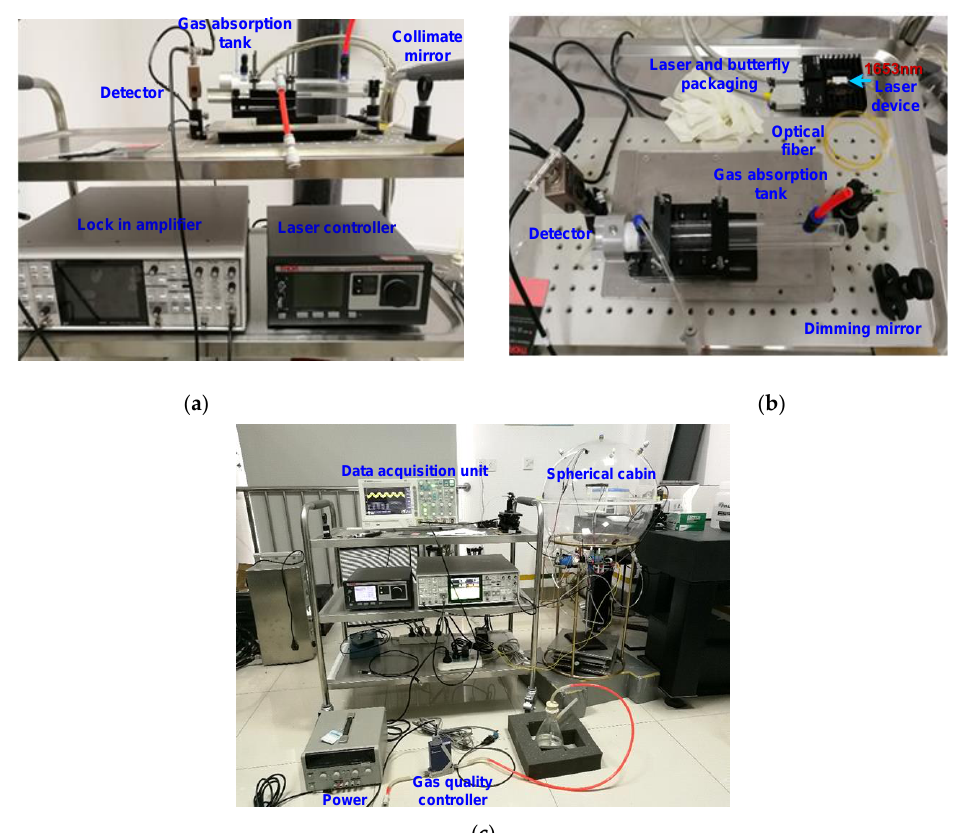
Figure 4. Measuring system: ( a ) Measuring instruments and platform; ( b ) measurement platform; ( c ) the actual setup of the entire system.